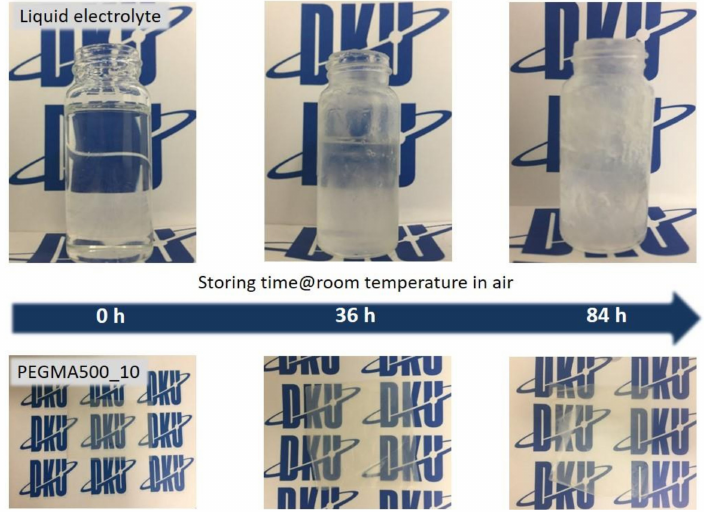
Figure 7. Digital camera images of the change in the state of the liquid electrolyte and